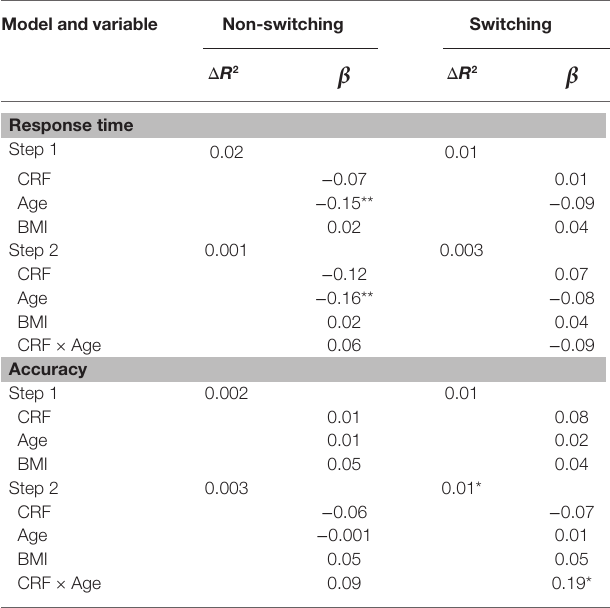
TABLE 3 | Regression analysis for the associations between cardiorespiratory fitness, age and Local-Global task. Model and